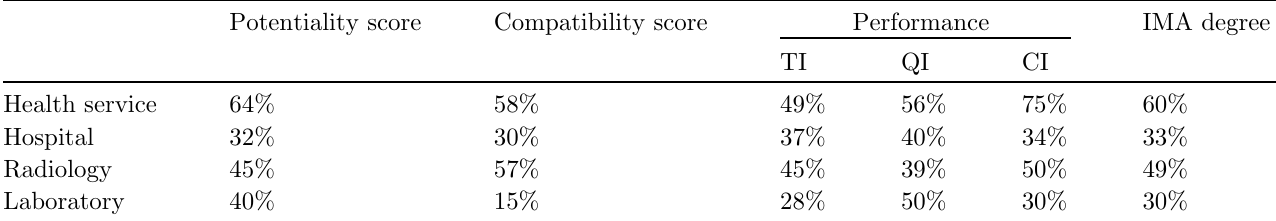
Fig. 3. Flowchart of Parallel PSO algorithm. Table 3. Degree of interoperability in “ surgical procedure ”